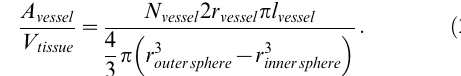
cuboid with hexagonal network